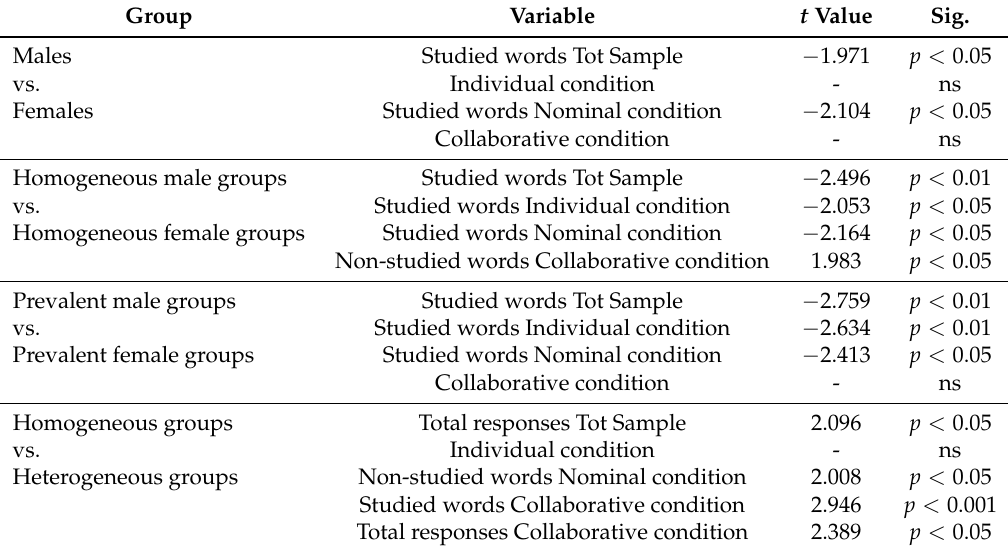
Table 4. Gender effect. The table shows the characteristics of the group composition in terms of gender and their effect on the subjects’ performance. A positive t value means that the group mentioned first in the table has, compared to the second group, a significantly higher average and vice